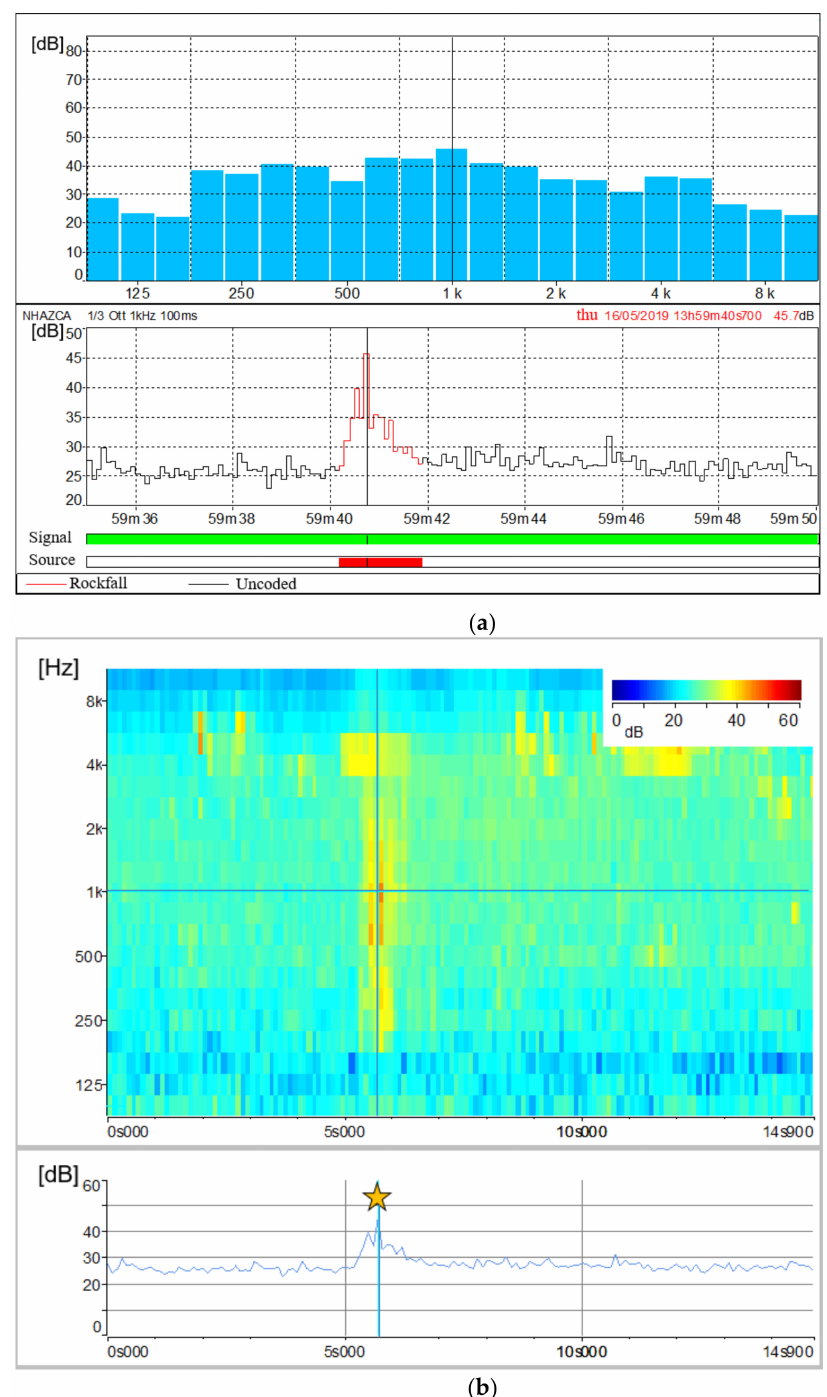
Figure 14. Overall representation of the acoustic signal emitted by the rockfall event on 16 May 2019 at 13:59 (UTC + 01:00): ( a ) Spectral time history of the rockfall event with the classified audio track (lower plot) and frequencies histogram (upper plot); ( b ) Focus on the audio track classified as rockfall by means of the sonogram showing the amount of sound pressure levels expressed in dB as a function of time and signal frequency. The plot at the bottom shows the amount of sound pressure levels over time at the frequency of 1 kHz. Yellow star refers to the time of the rock block detachment. Temporal resolution is 0.1